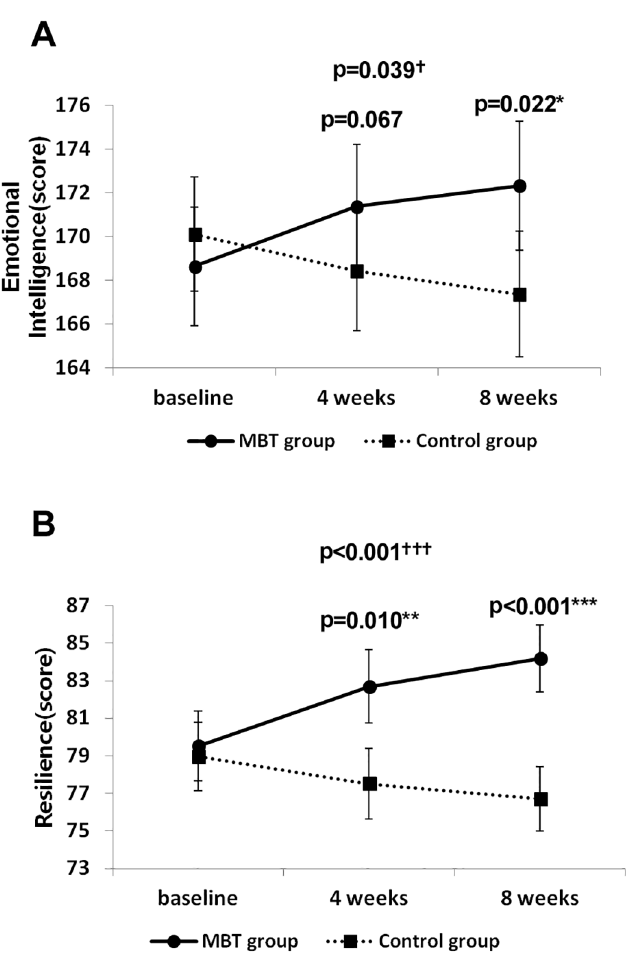
Fig 3. Change in emotional intelligence (A) and resilience (B) scores for the MBT and control groups across the 8 weeks. (A) Significant changes for 8 weeks in emotional intelligence (total score of 5 factors). (B) Significant changes for 8 weeks in resilience (total score of 5 factors). † : Tests of within-subjects effects (time x group). * : Tests of within-subjects of contrasts (time x